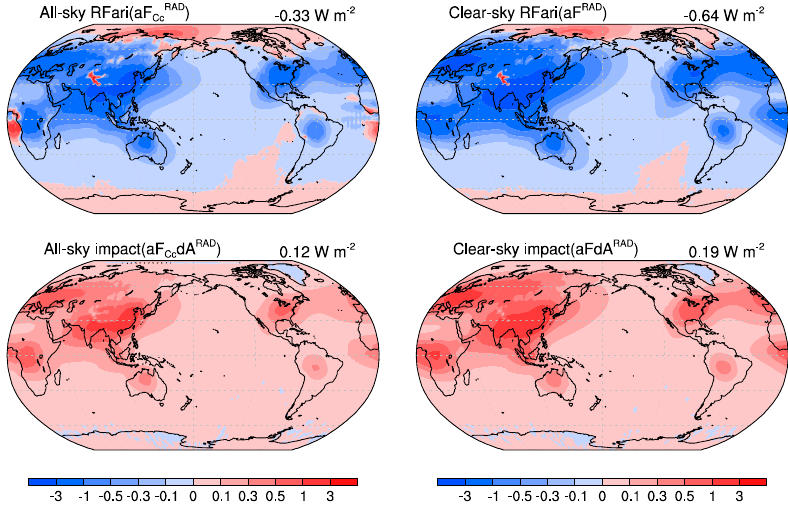
Figure 2. As in Figure 1 but for the all-sky ( left ) and clear-sky ( right ) instantaneous direct radiative effect without the natural aerosol radiative effect (RFari, upper panels) and the impact of the natural aerosol radiative effect on calculating RFari (lower panels).